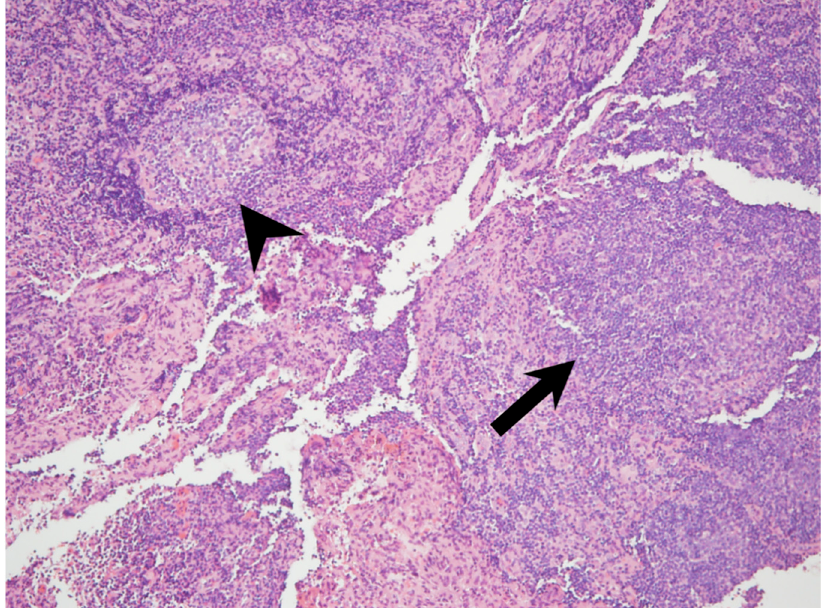
Figure 3. Microscopic examination revealed reactive follicular hyperplasia (arrowhead) and the presence of small clusters of epithelioid histiocytes (arrow) in the affected lymph node (original magnification ×40).